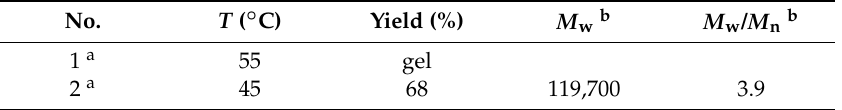
Table 1. BCl 3 -mediated polymerizations of 1 and 2 at different temperatures.